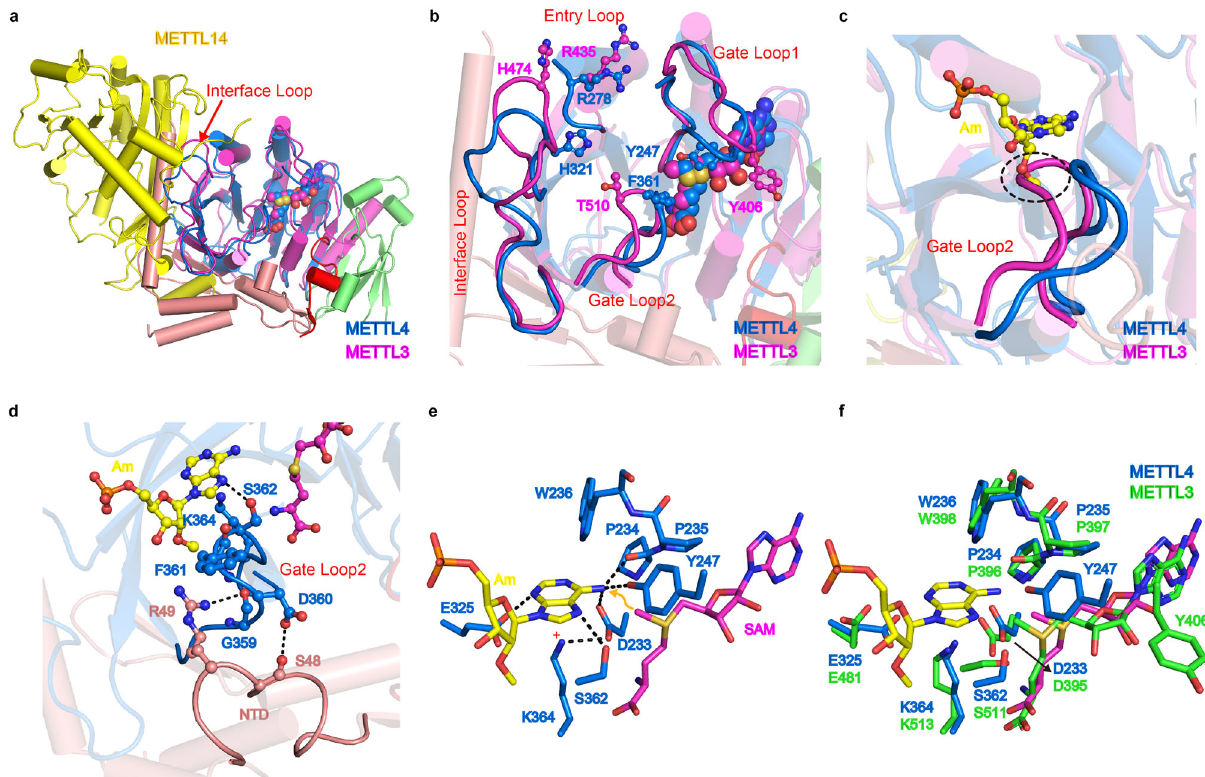
Fig. 4 | Structural comparison of METTL4 and METTL3/METTL14. a Superposition of the METTL4 with METTL3-METTL14 heterodimer. b Close-up view of the catalytic pocket formed by the four loops in the MTase domains of METTL4 and METTL3, and the key residues were shown as sticks. c Structural